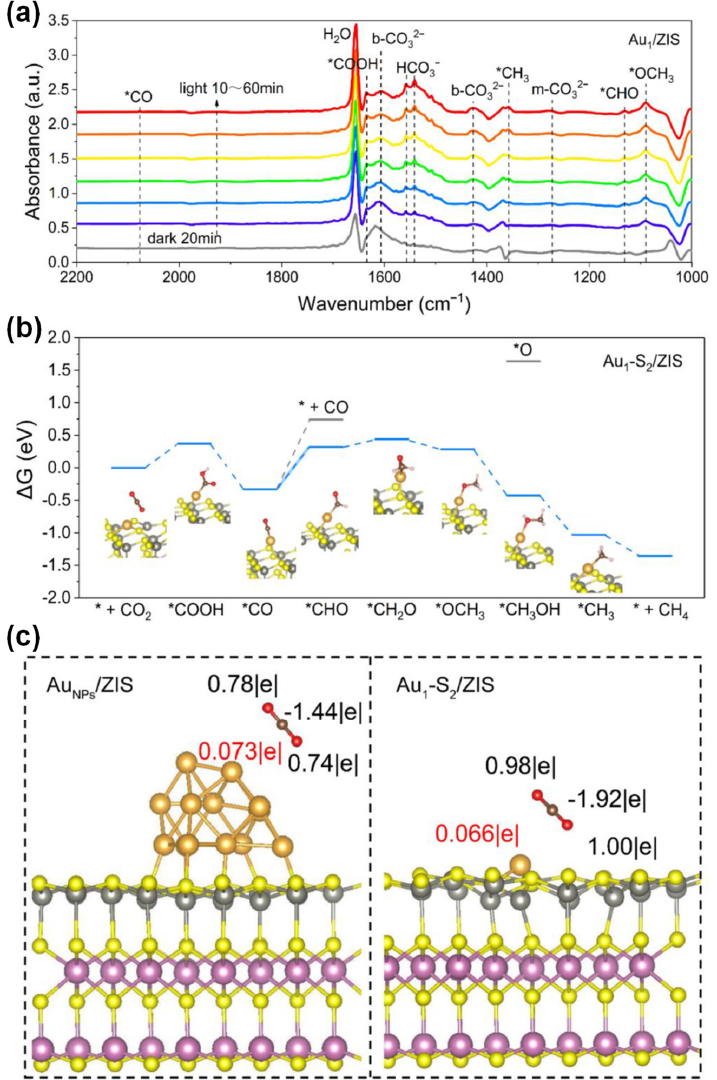
Figure 6. ( a ) In-situ DRIFTS for dynamic observation on the reaction intermediates during photo- catalytic CO 2 reduction over Au/ZnIn 2 S 4 ; ( b ) Free energy diagrams of photocatalytic CO 2 to CH 4 for Au/ZnIn 2 S 4 ; ( c ) Optimized adsorption configurations of CO 2 molecules with their corresponding charge distribution on the surface of AuNPs/ZnIn 2 S 4 and Au/ZnIn 2 S 4 [46]. Copyright 2022, Wiley- VCH.